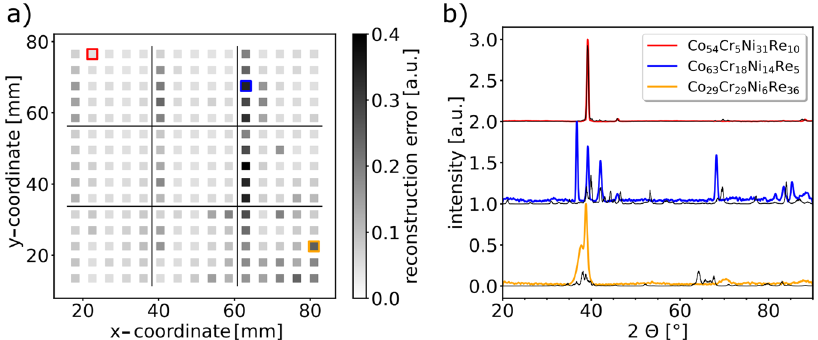
Fig. 4 XRD pattern reconstruction by VAE and reconstruction error as a measure of novelty. a Materials library map of reconstruction error. Each position marks the measurement area where an XRD pattern was acquired for a unique chemical composition within the library. b Experimental XRD patterns (color-coded) and VAE reconstructed-XRD patterns (black) of highlighted data points on materials